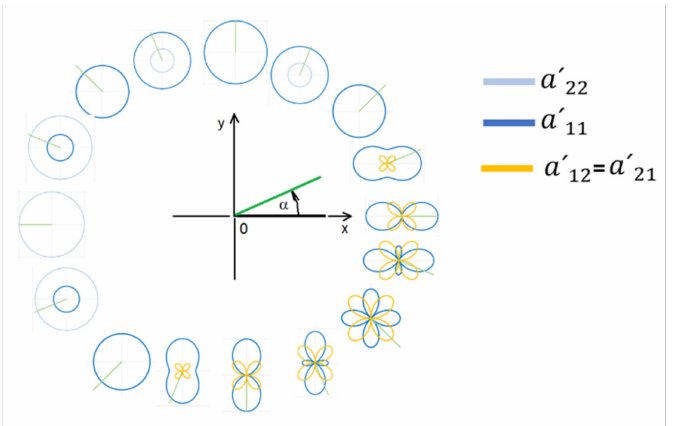
Figure 4. Change in the form of tensor glyph of a symmetric tensor depending on angle α